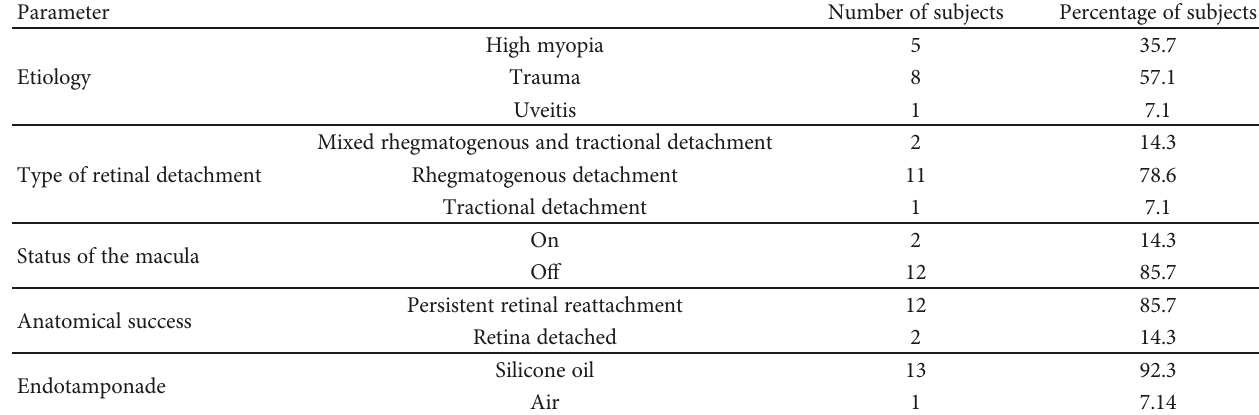
Table 1: Characteristics of retinal detachment (RD) in a presented study group of 14